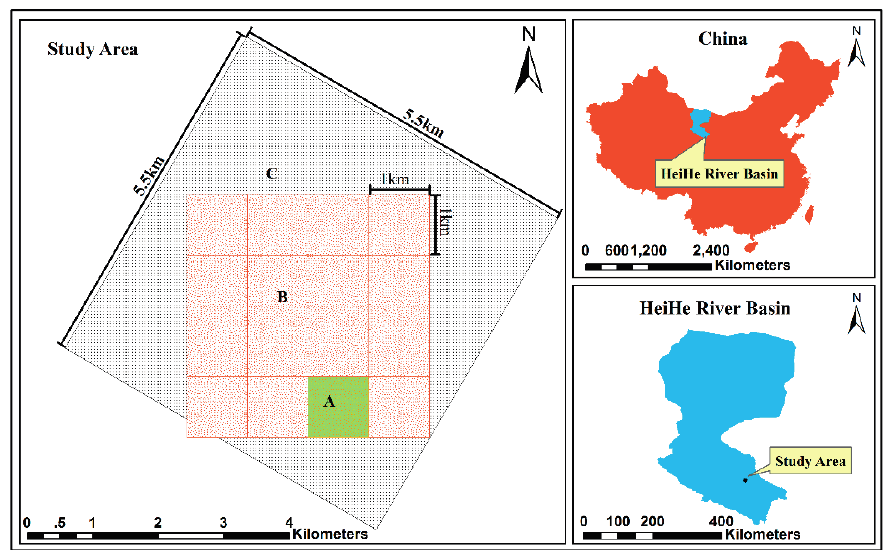
Figure 1. Map of the observation matrix